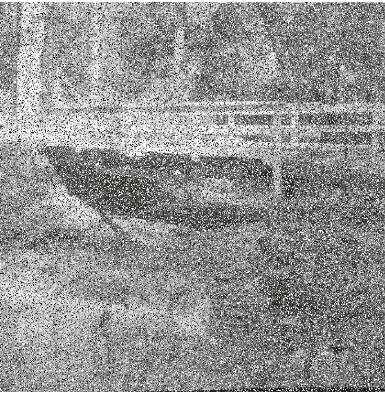
Figure 2: Test image Bridge corrupted with 40% of mixed impulse